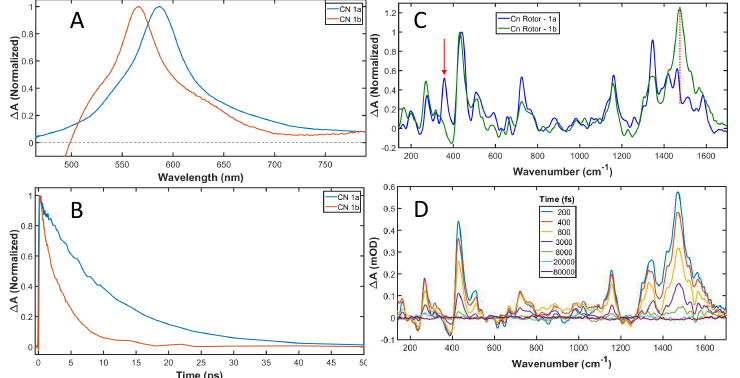
Figure 2 . A. TA data measured at 100fs for the 1a-CN (blue) and 1b-CN (orange) states. B. Decay kinetics, where the faster decay following excitation of 1b-CN is evident. C. Comparison of FSRS averaged between 100 and 500 fs for 1a-CN and 1b-CN . D. Transient FSRS data for 1b-CN